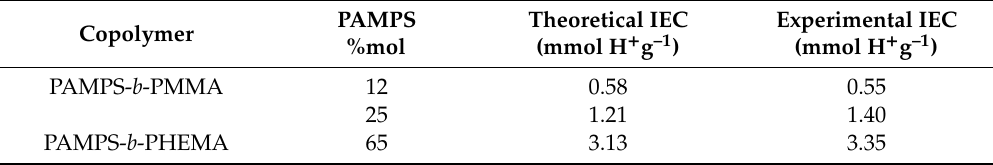
Table2. Ionexchangecapacity(IEC)ofPAMPS- b -PMMAandcrosslinkedPAMPS- b